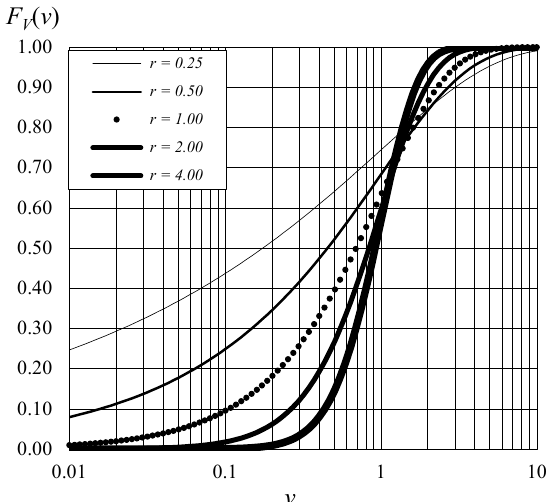
Figure 3. Suspended solids settling velocity distribution function for five values of the parameter r [26].